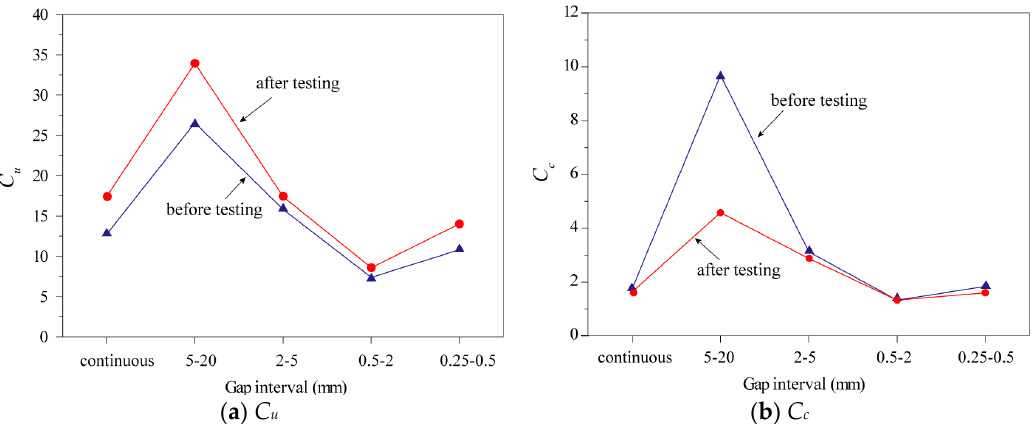
Figure 4. Changes of non-uniform coefficients C u and coefficients of curvature C c after vibrating compaction.